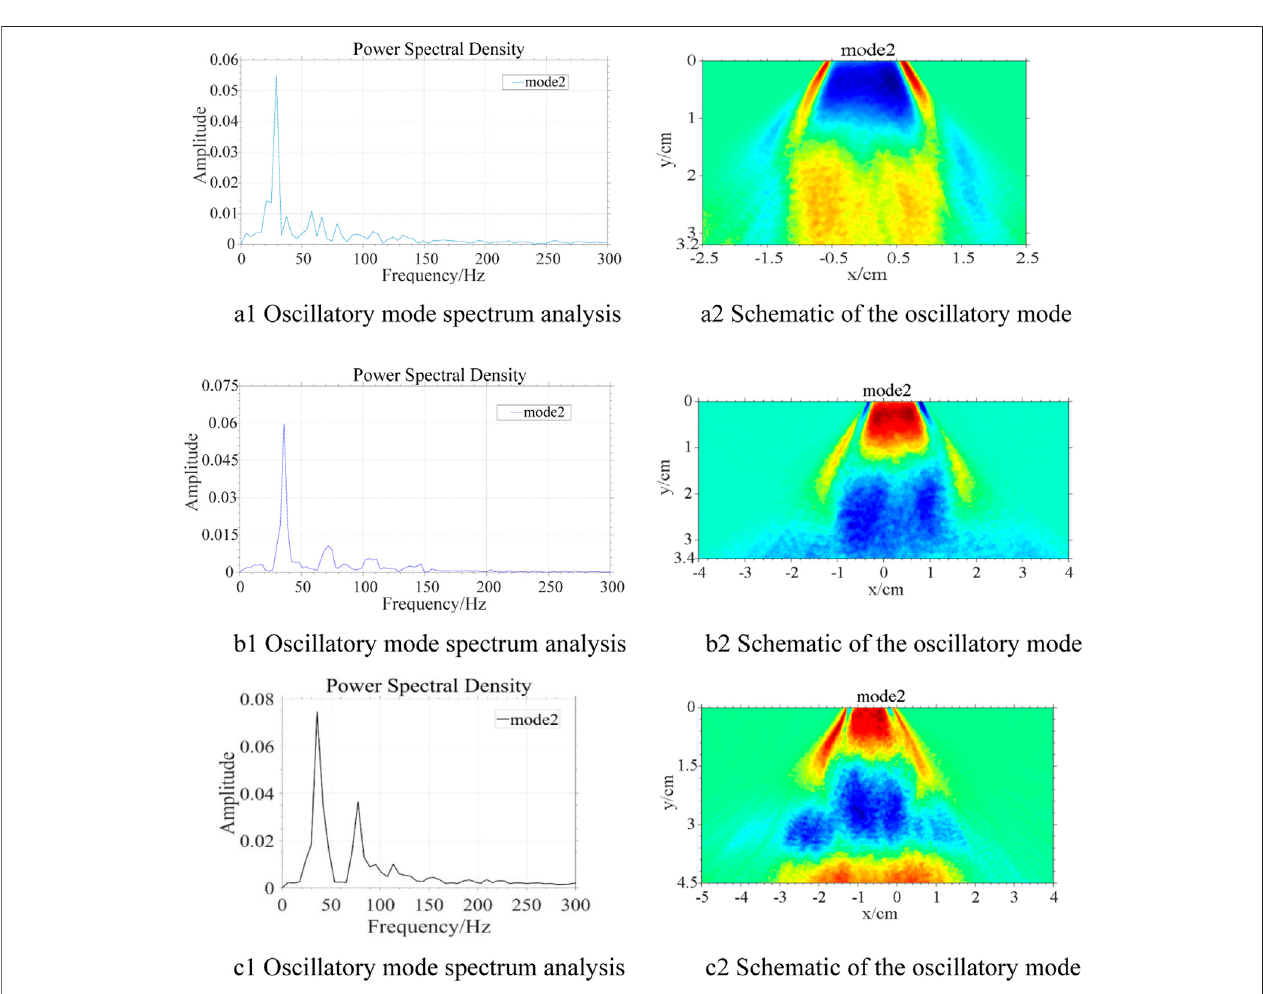
FIGURE12| Theself-oscillationcharacteristics(oscillatorymodespectrumandoscillatorymode)ofdifferentinjectorswhentheaircoresizeis (A) 7 mm, (B) 6 mm, and (C) 5 mm.